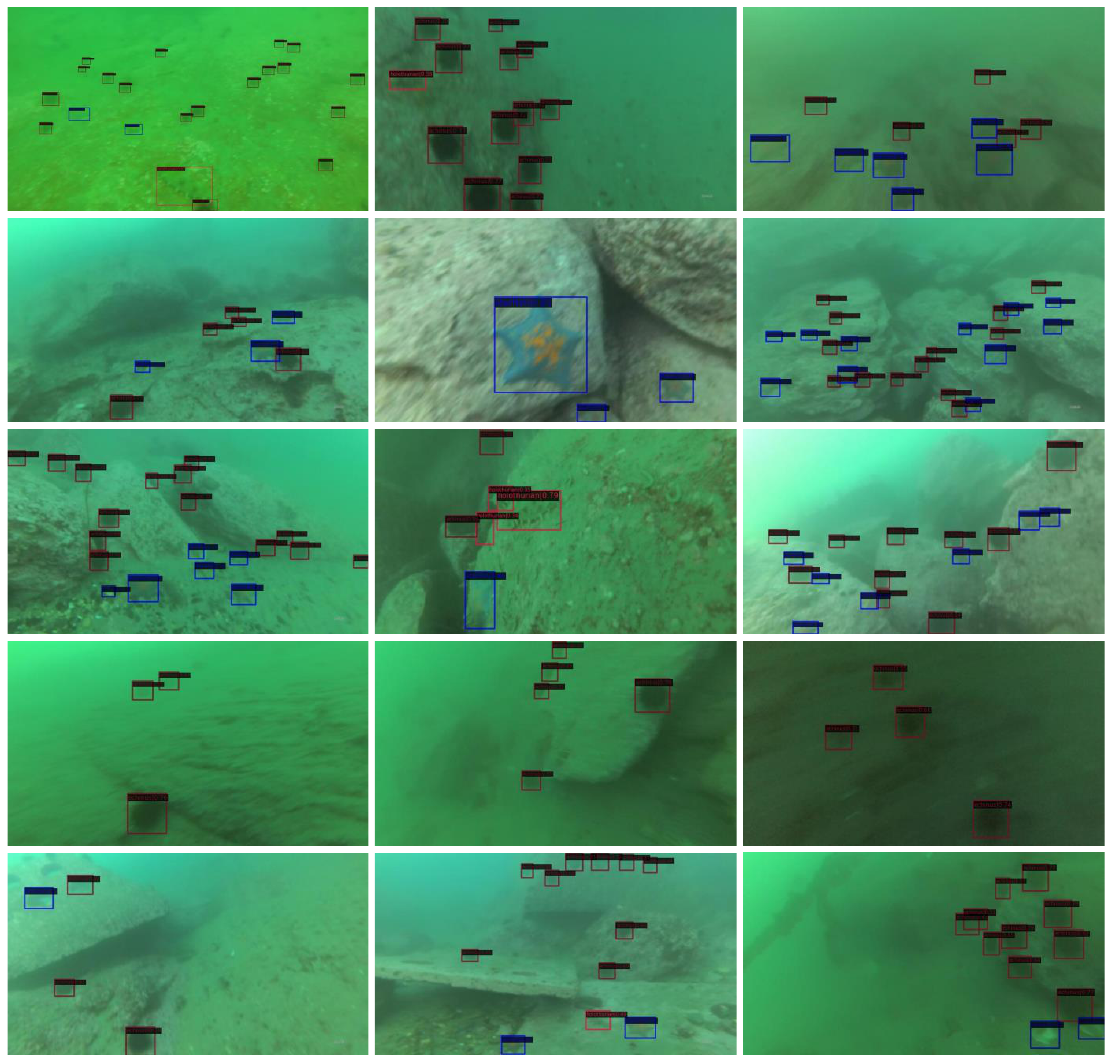
Figure 14. Detection results of our proposed model on the URPC 2018 dataset. The blue boxes are starfish and the red boxes are echinus. Almost all objects are located with a bounding box, although for some objects, it is hard to pick it out. Our detector achieved relatively good qualitative